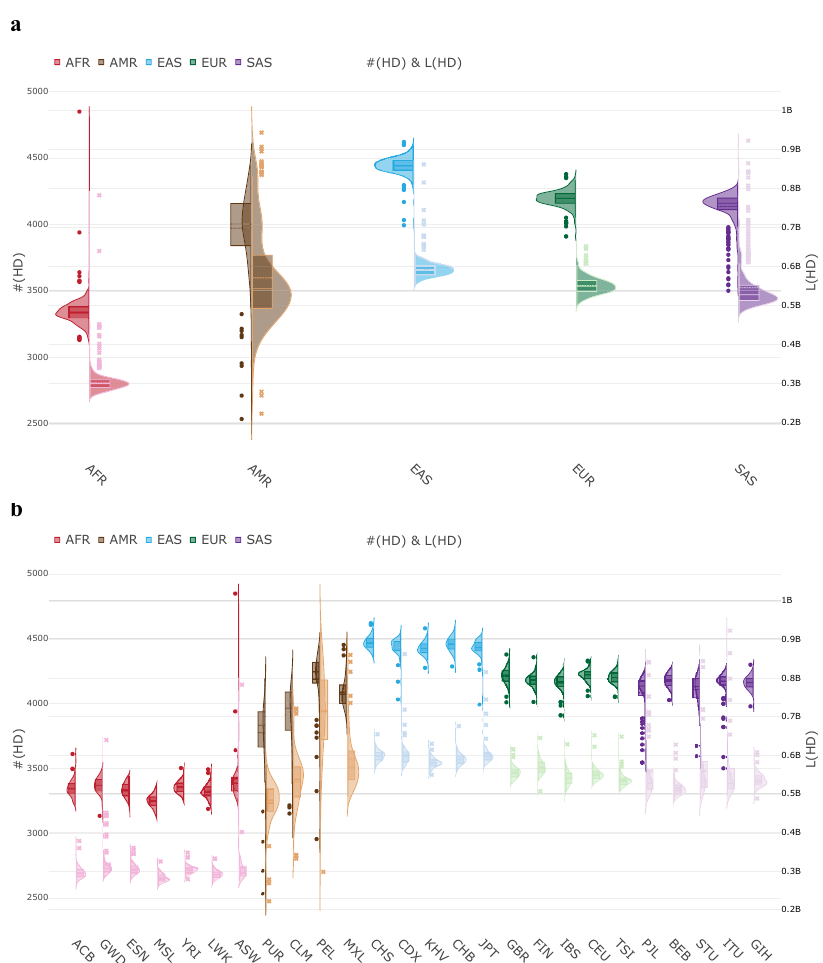
Fig. 6 Genome-wide distributions of the number and length of regions of HD. a Distributions of HD in the fi ve continental ancestry groups. b Distributions of HD in all populations in the fi ve continental ancestry groups. For each continental ancestry group or population, the number of regions of HD, i.e., #(HD), is displayed on the left-hand side of a violin plot with respect to the left y-axis. The length of regions of HD, i.e., L(HD), is displayed on the right-hand side of a violin plot with respect to the right y-axis. Sample size n = 2504